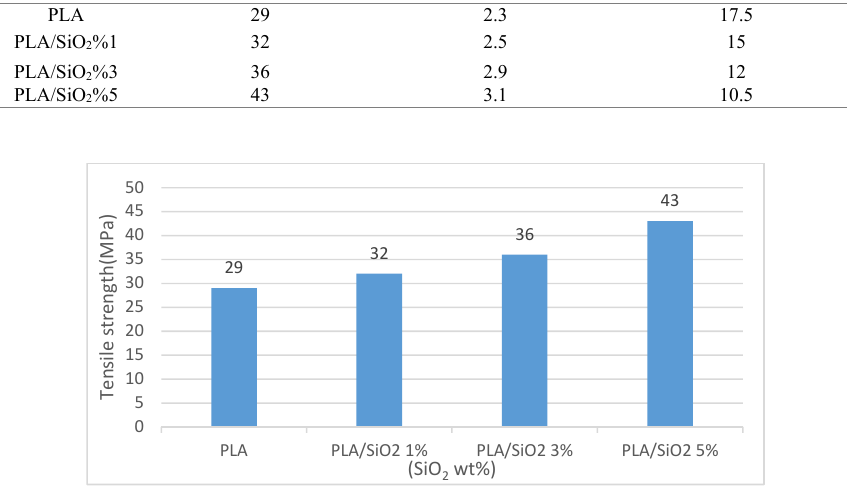
Fig. 2. Comparison of average of tensile strength for poly lactic acid films containing silicon dioxide